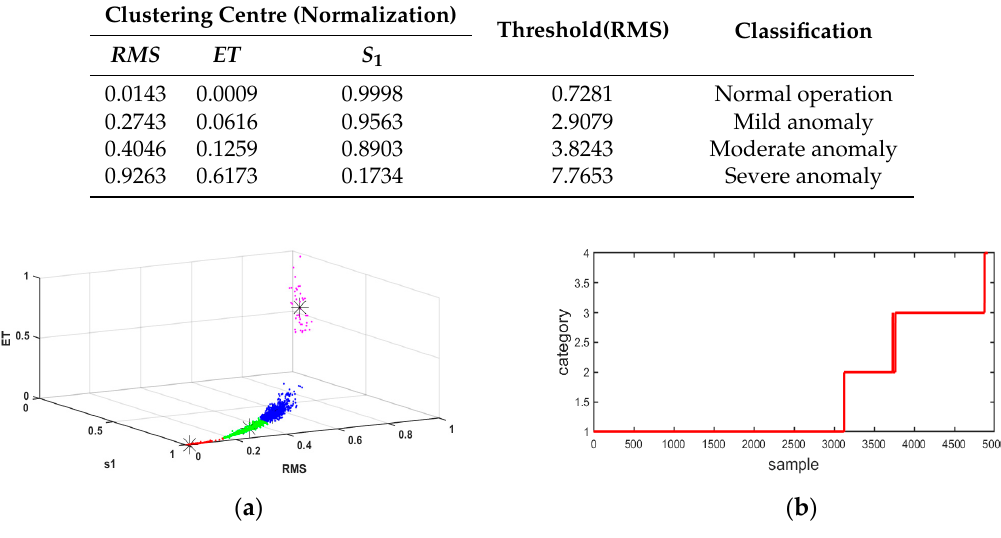
Figure 6. Results of k-means clustering analysis: ( a ) spatial representation of clustering results; ( b ) temporal variation of different categories. Table 6. Historical data clustering centres and thresholds.